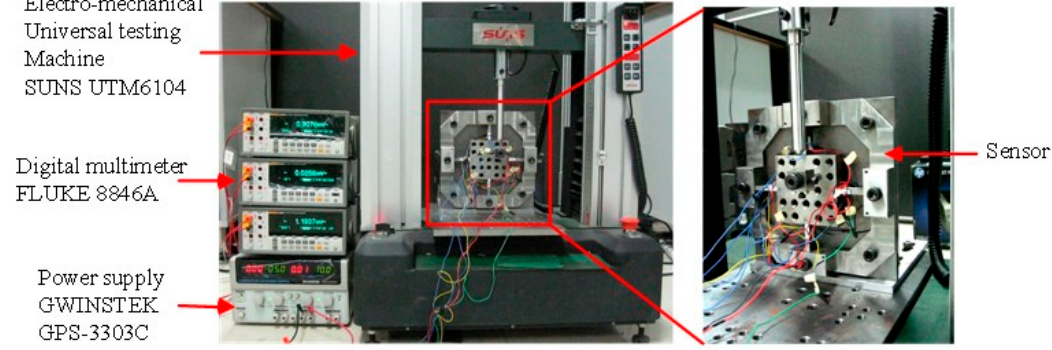
Figure 7. Experimental setup for static calibration.